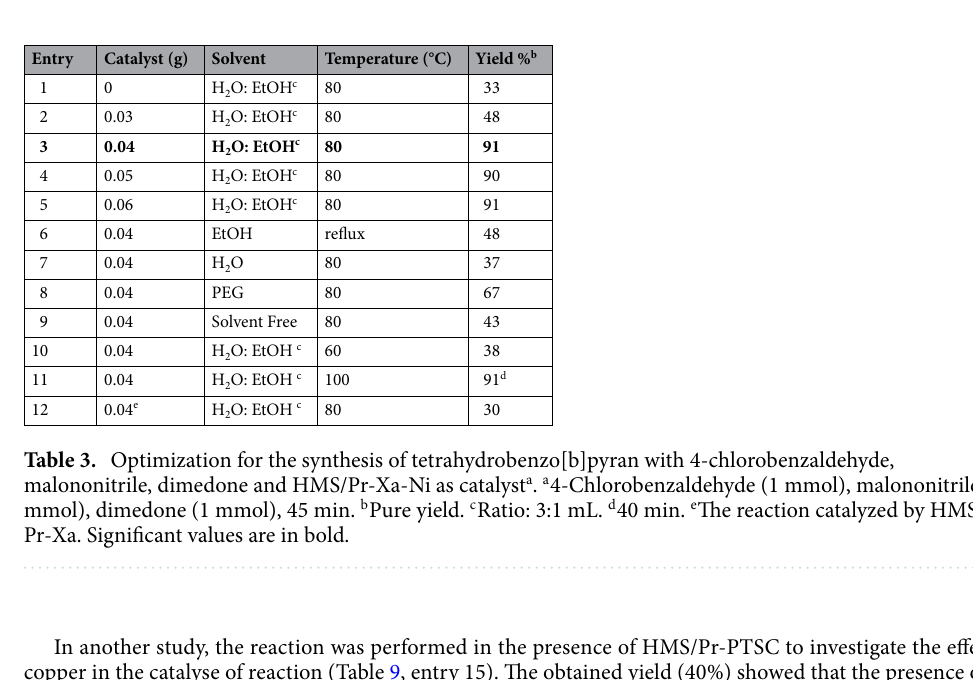
Figure 18. Nitrogen adsorption–desorption isotherm of HMS/Pr-PTSC-Cu.